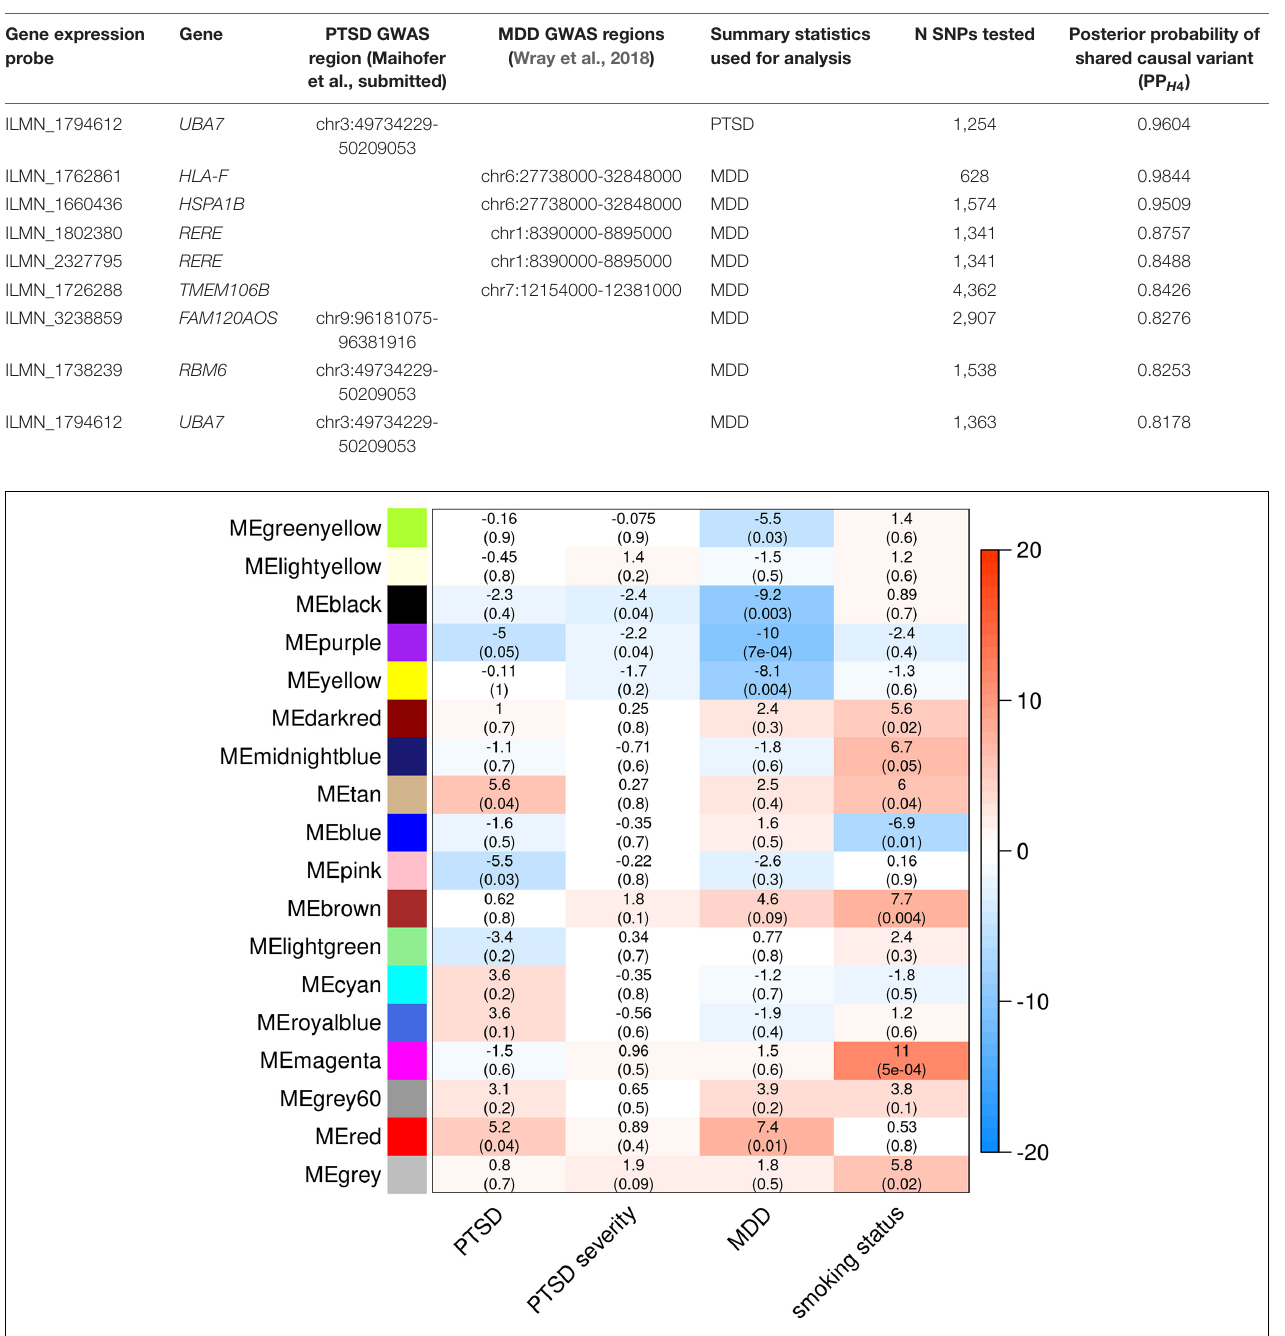
FIGURE 2 | Co-expression modules detected in NHW MIRECC/Duke subjects and subsequent associations with PTSD, PTSD severity, MDD, and smoking status. The heatmap color scale represents effect sizes of each association (betas are listed in each cell, followed by corresponding p -value in